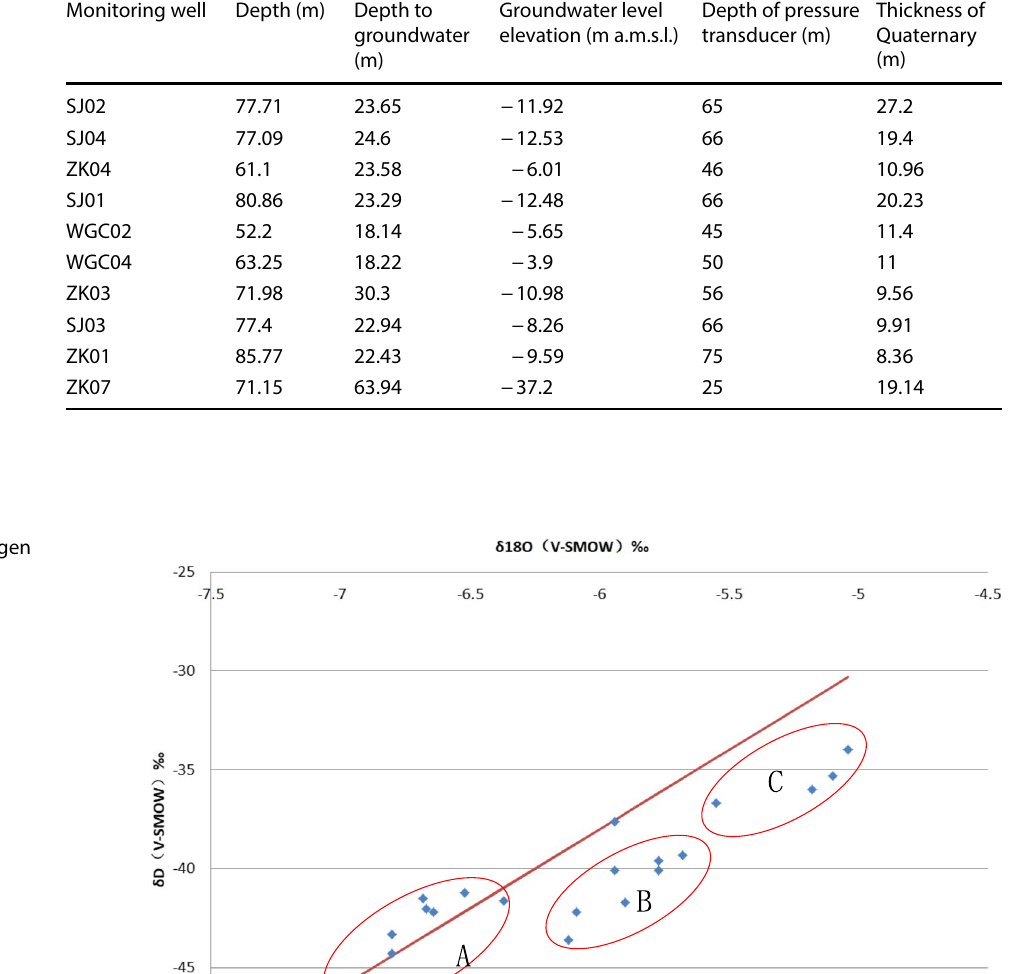
Table 3 Features of monitoring borehole